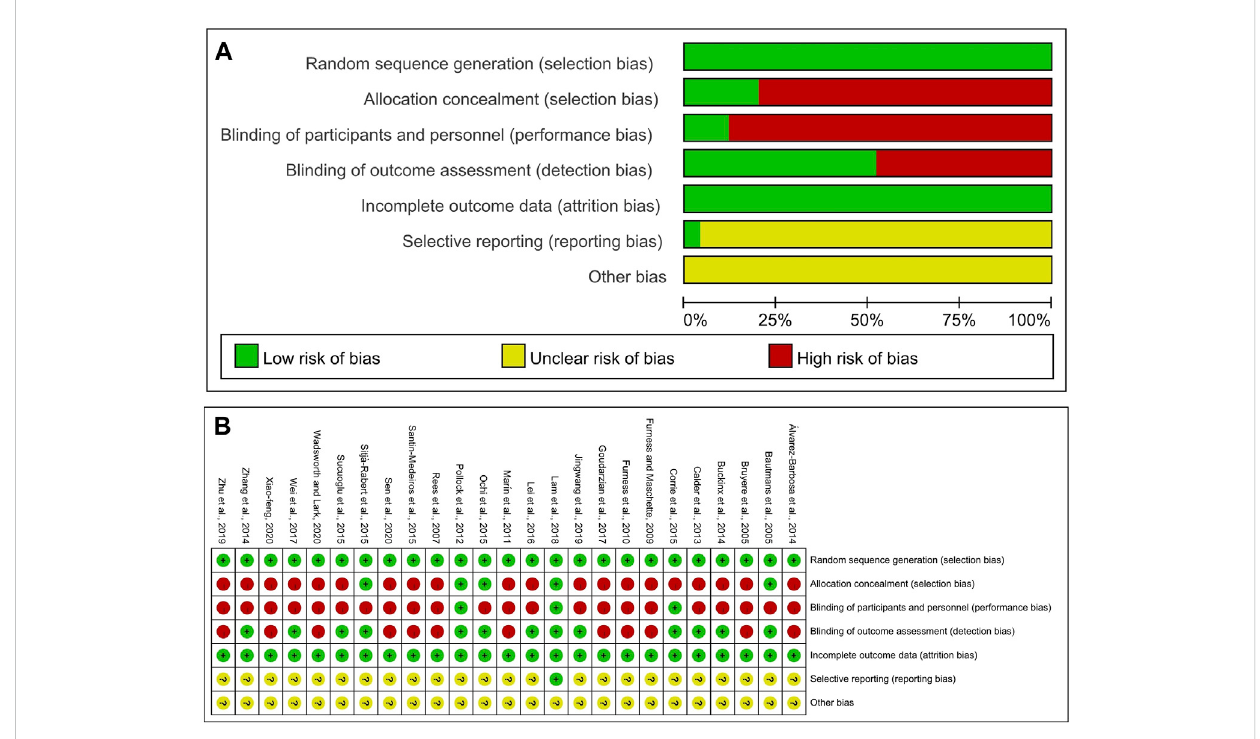
FIGURE 2 Rias of bias assessment results. (A) Risk of bias graph; (B) Risk of bias summary.